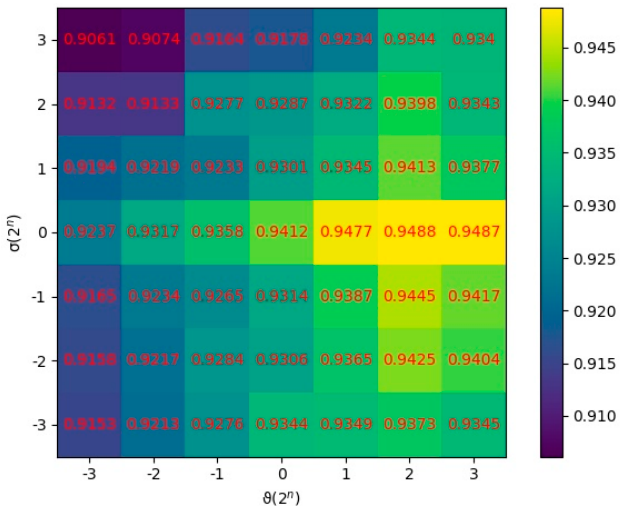
Figure 4. AUCs at different values of ϑ and σ .